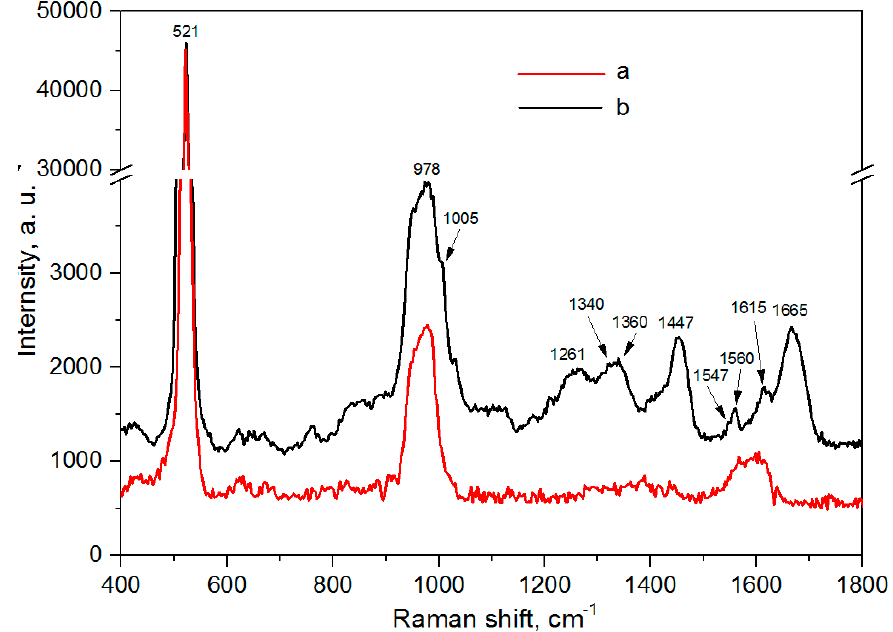
Figure 6. SERS spectra of the silvered por -Si: ( a ) Virgin; ( b ) after adsorption of the lactoferrin molecules from the 10 –6 M solution.